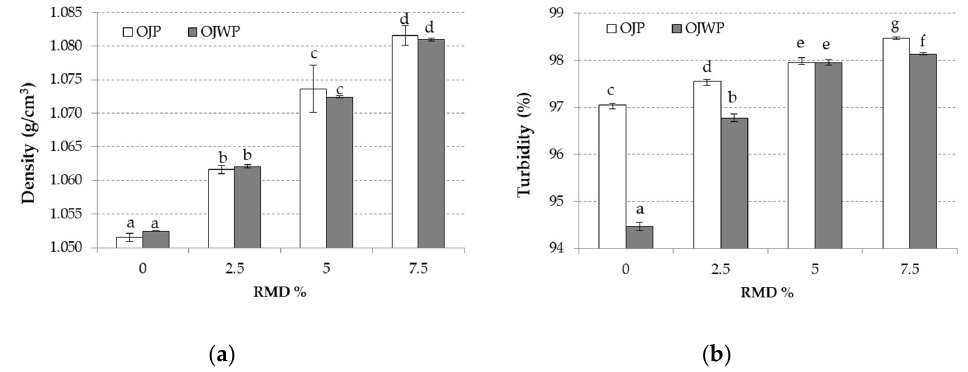
Figure 2. ( a ) Mean values (and standard deviations) of density of pasteurised orange juice; ( b ) Mean values (and standard deviations) of turbidity of pasteurised orange juice. Letters indicate homogeneous groups established by the ANOVA ( p < 0.05) for each parameter analysed. OJP, orange juice with pulp; OJWP, orange juice without pulp.